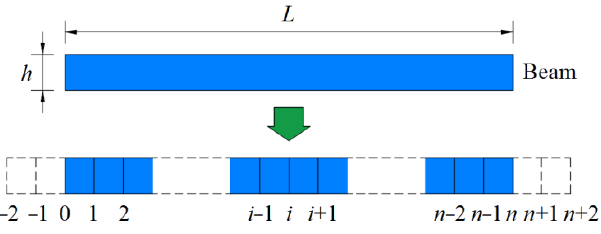
Figure 5. Discretization of beam.